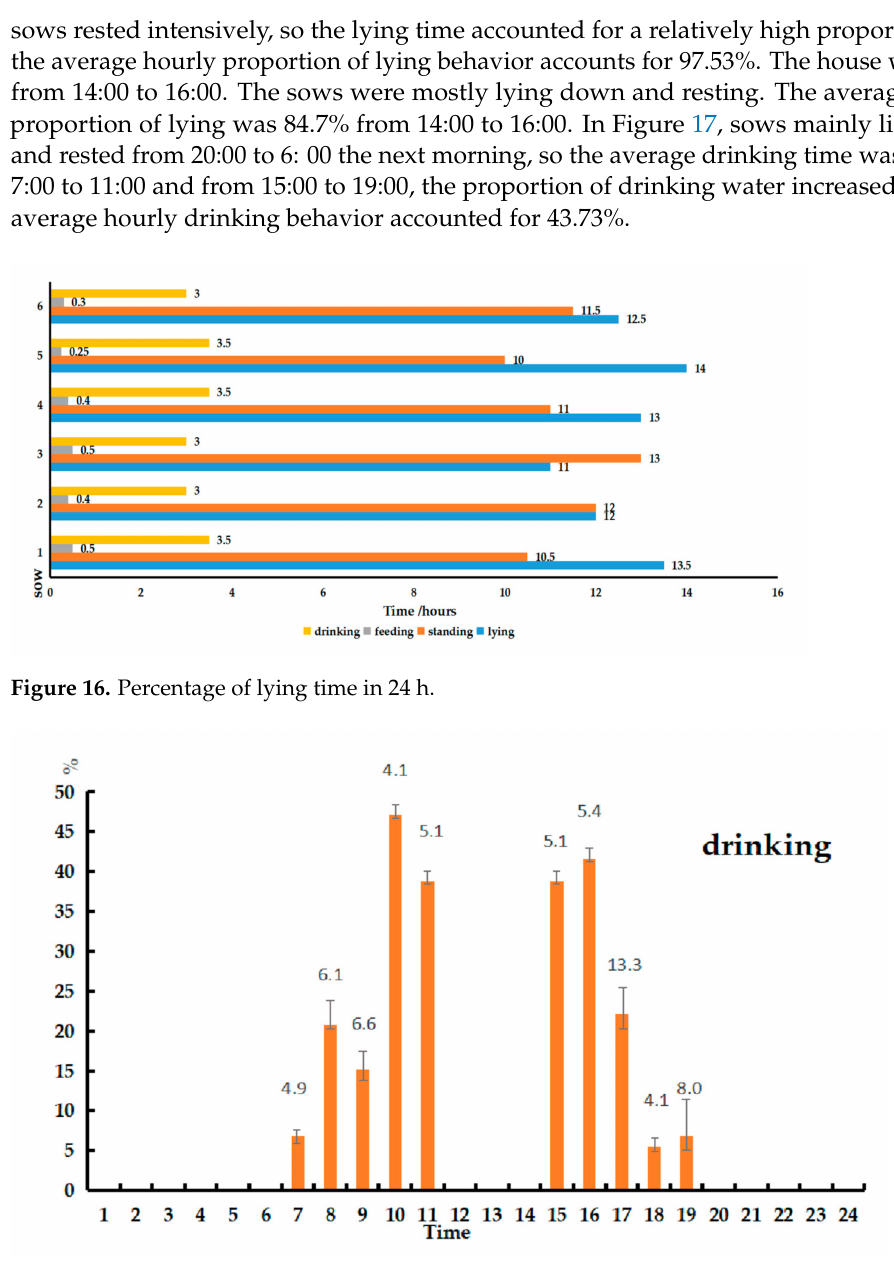
Figure 17. Percentage of drinking time in 24